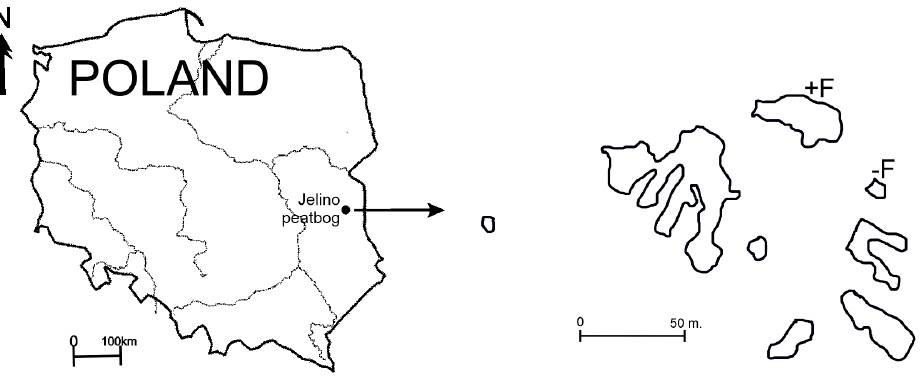
Figure 1. Location of the study area; − F treatments without fish, +F treatments with